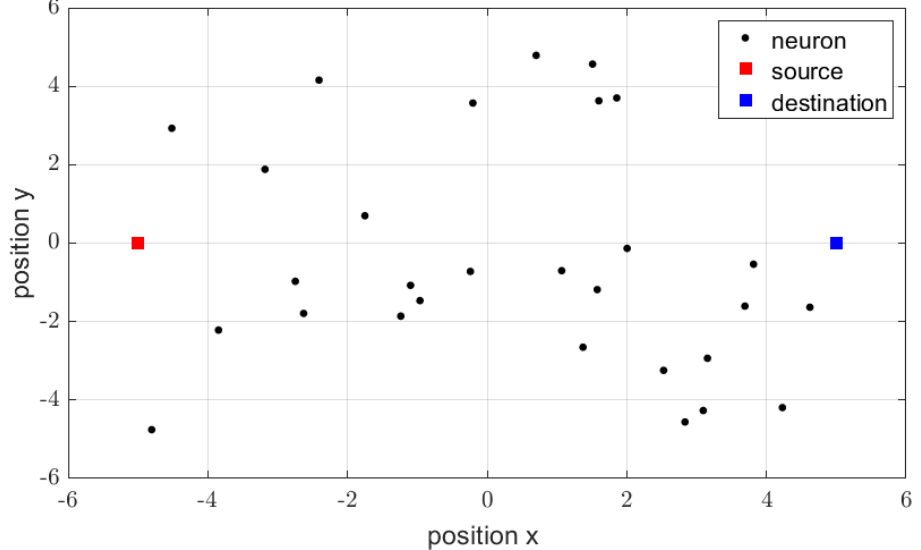
Figure 2. Example of the analyzed